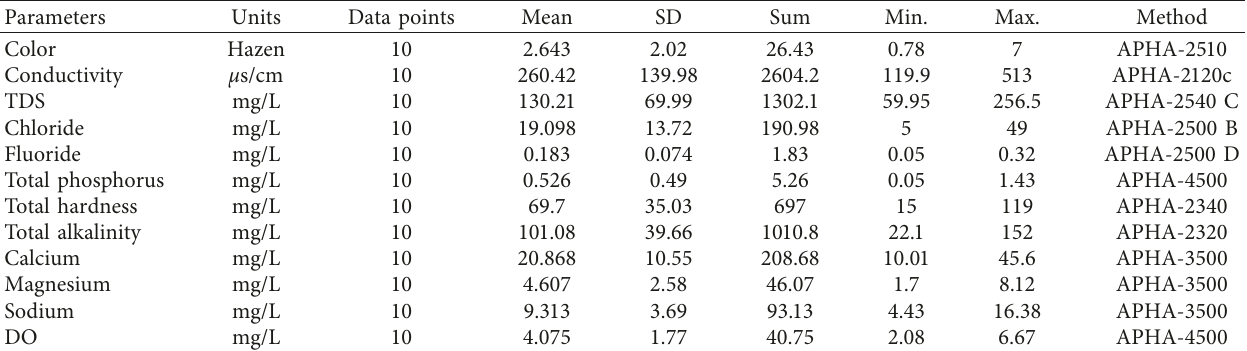
Table 2: Statistical summary of the measured parameters of 10 water samples from Ratuwa, Haat Khola, Dipeni, Betani, and Dhukure